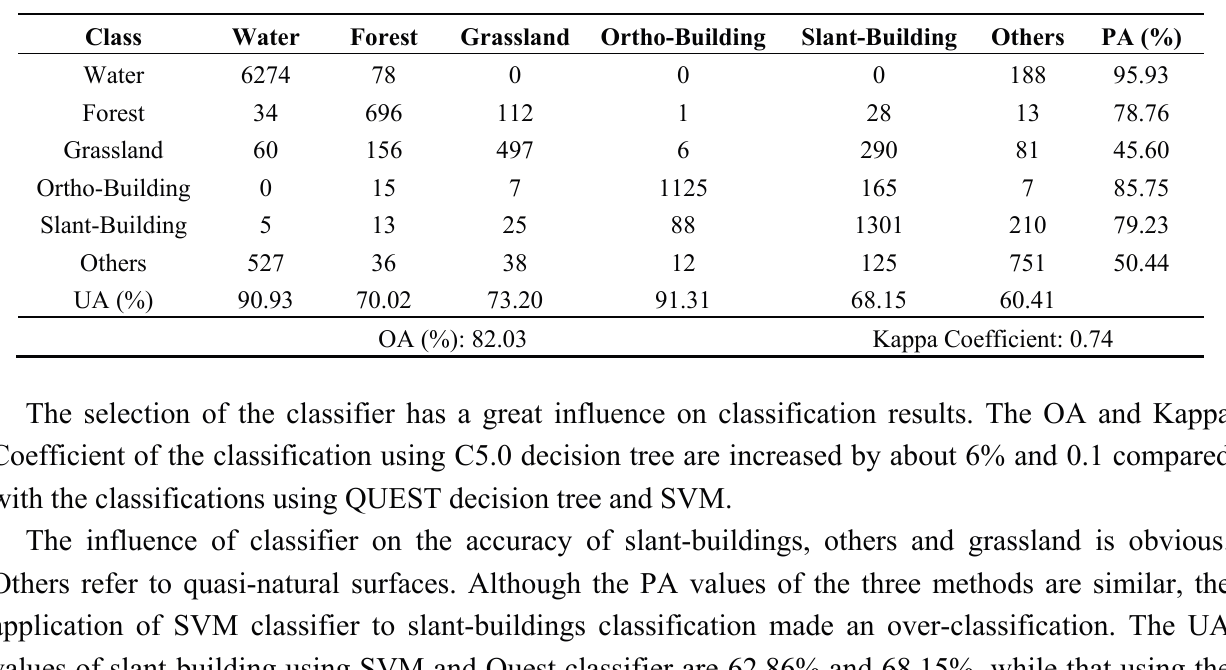
Table 6. Confusion Matrix of Classification Method using Quest. (PA = producer’s accuracy, UA =user’s accuracy, OA =overall